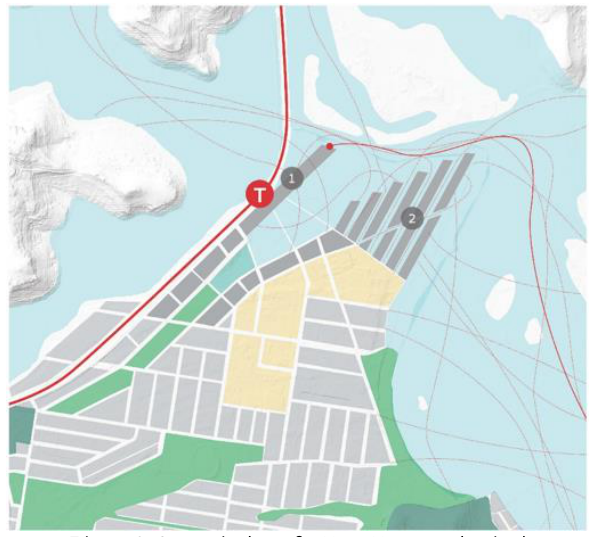
Figure 6: Scenario three for Woy Woy emphasised “Amphibious living”.